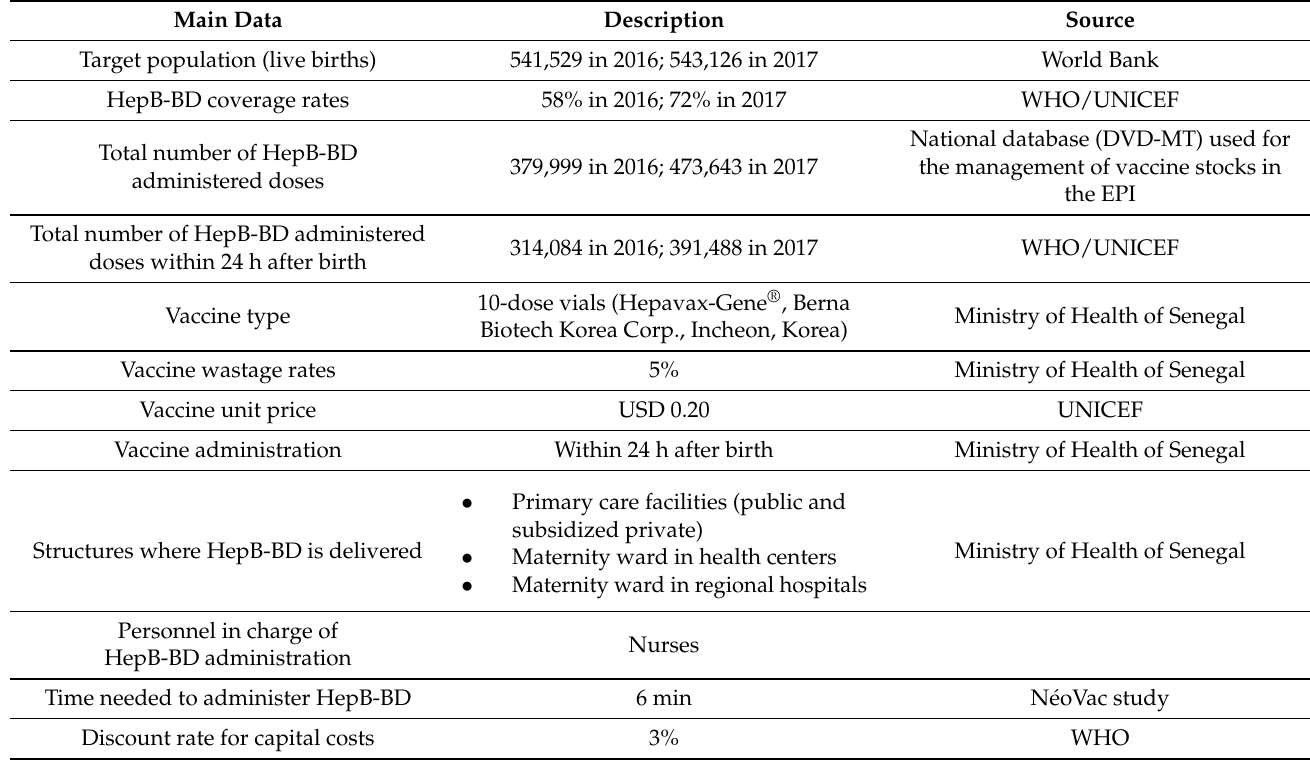
Table 2. Main data used in the costing analysis of hepatitis B birth dose introduction in